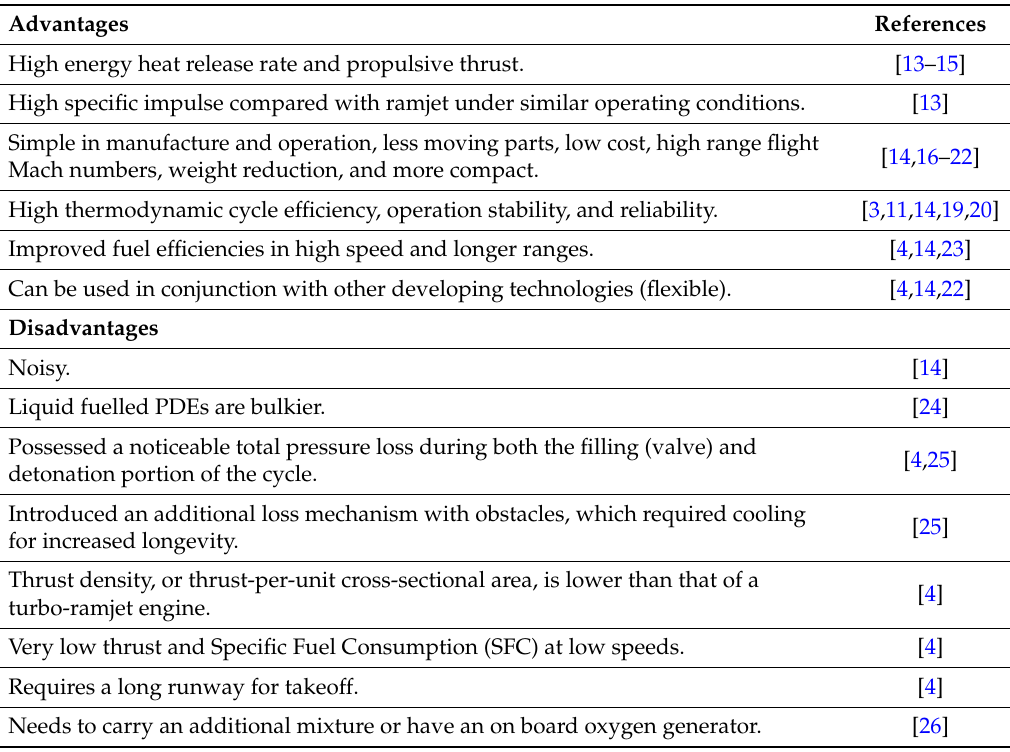
Table 1. PDE Advantages and